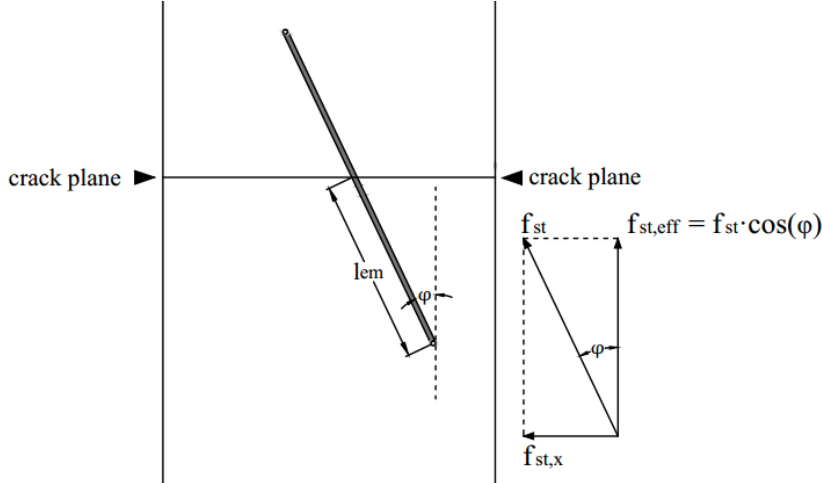
Figure 16. Effective embedment length of fibres inside the concrete matrix in the uniaxial tensile test in fibre activation stage.